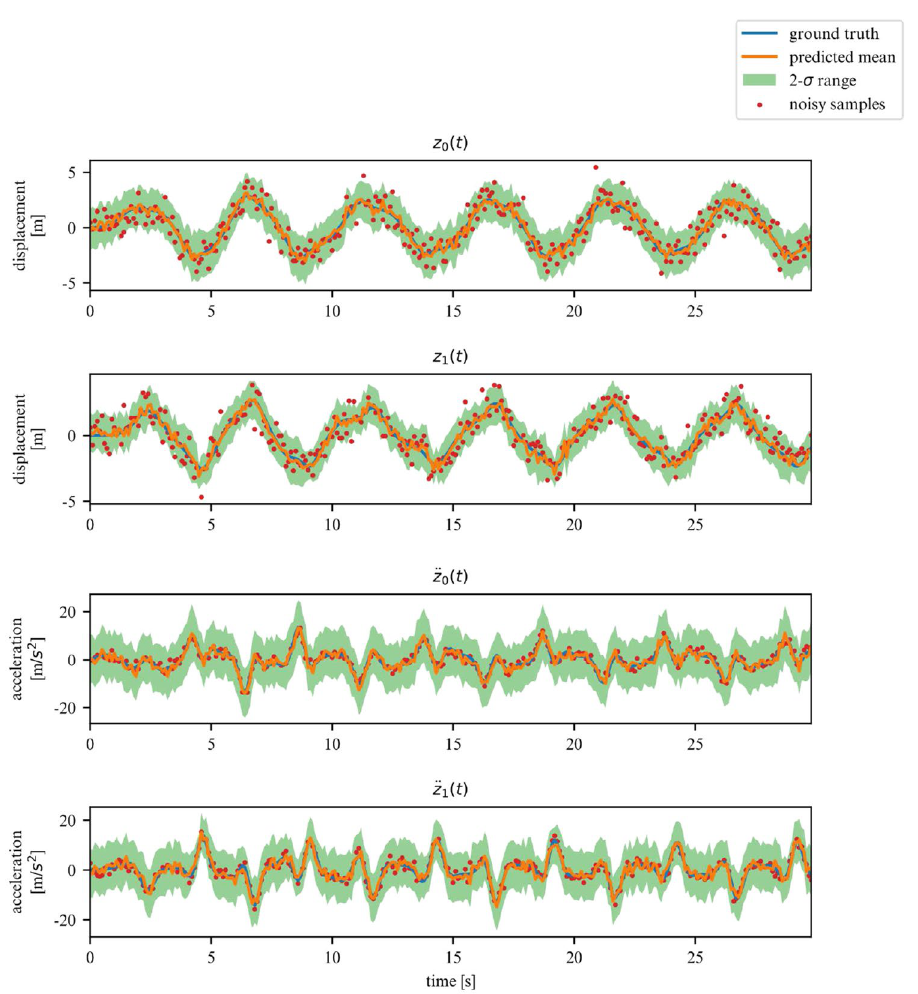
Figure 25. Forced dissipative 2DOF system observations for γ = 0.3